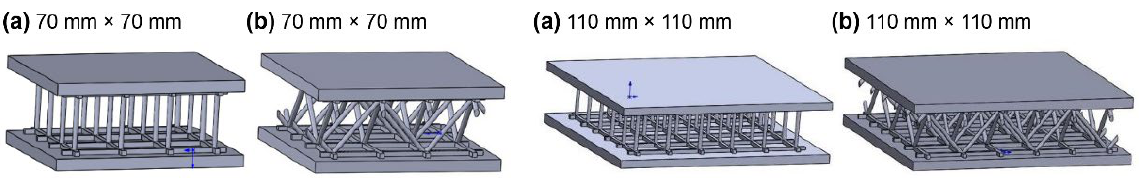
Figure 12. Flat compression simulation models. the double-sided, square shallow groove, and cylindrical deep holes ( a ) and optimized Warren truss with symmetrically inclined holes ( b ) resin stiffener structures.